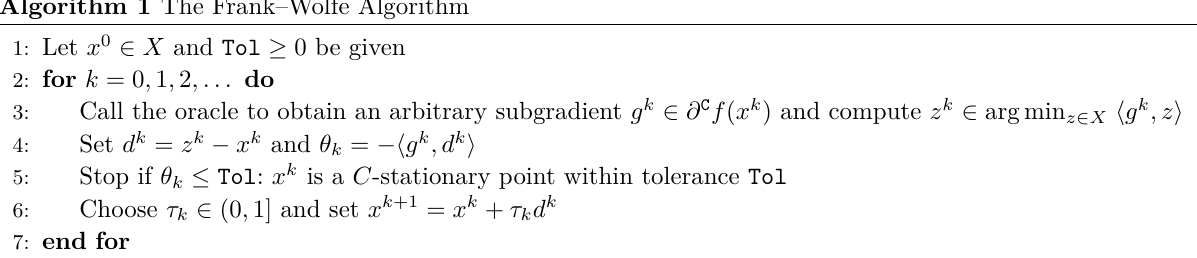
Algorithm 1 The Frank–Wolfe